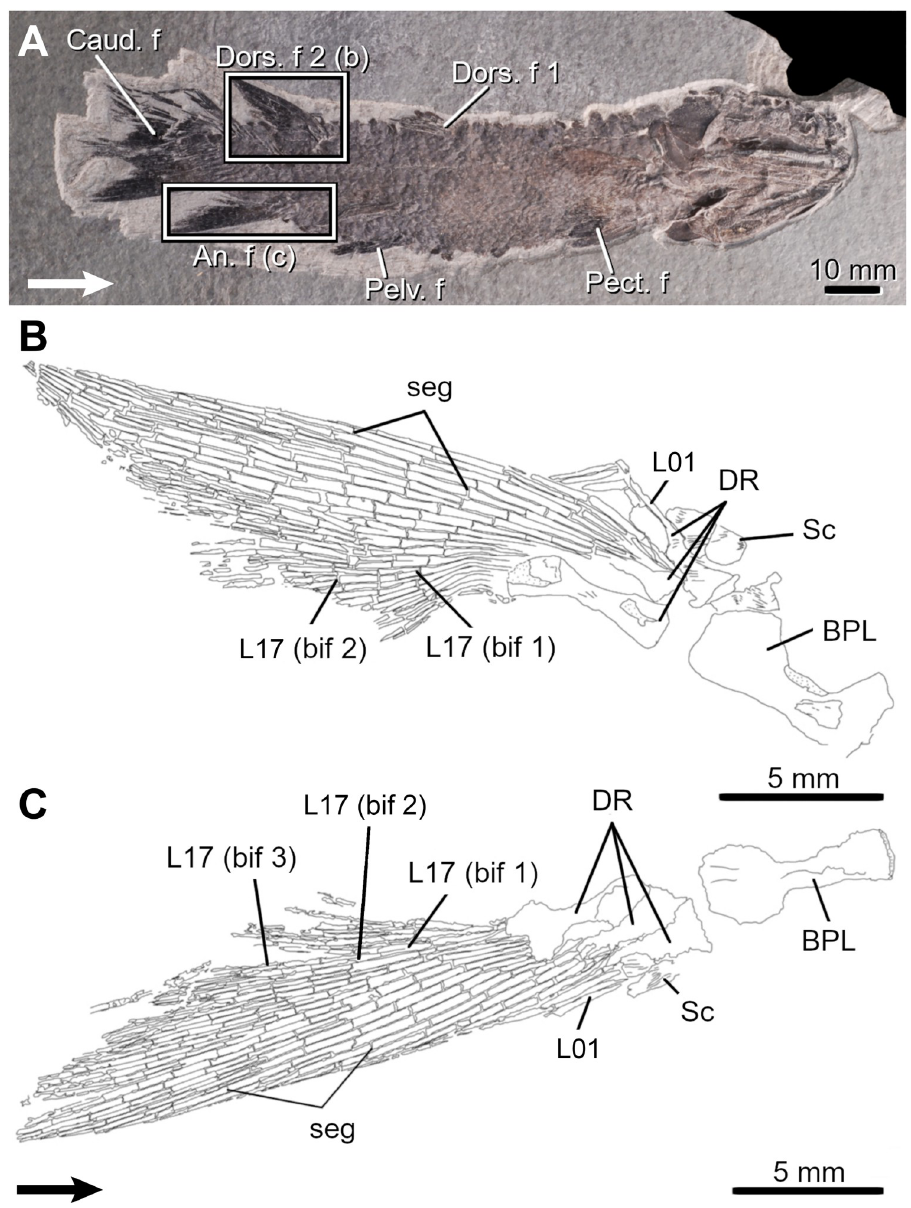
Fig 11. The Devonian ‘osteolepiform’ Eusthenopteron foordi . A, Small fossil specimen (MHNM 06–1769) and drawings of its second dorsal (B) and anal (C) fins. Arrows point anteriorly. Note the preservation of a basal plate (BPL) and a reduced scale covering (Sc) at the base of the fins. An. f, anal fin; bif, bifurcation; Caud. f, caudal fin; Dors. f, dorsal fin; DR, distal radial; L, lepidotrichia; Pect. f, pectoral fin; Pelv. f, pelvic fin; PR, proximal radial; seg,